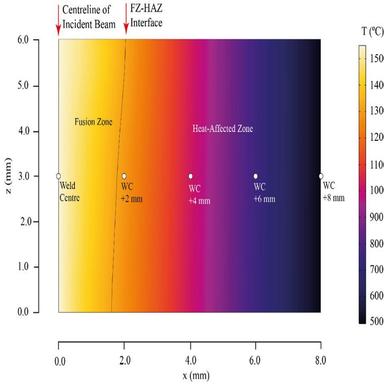
Cross-section through the centre of the plate (y = 50 mm) at peak temperature, showing FZ-HAZ interface and locations of selected virtual temperature probes (WC + 10 mm omitted for clarity).